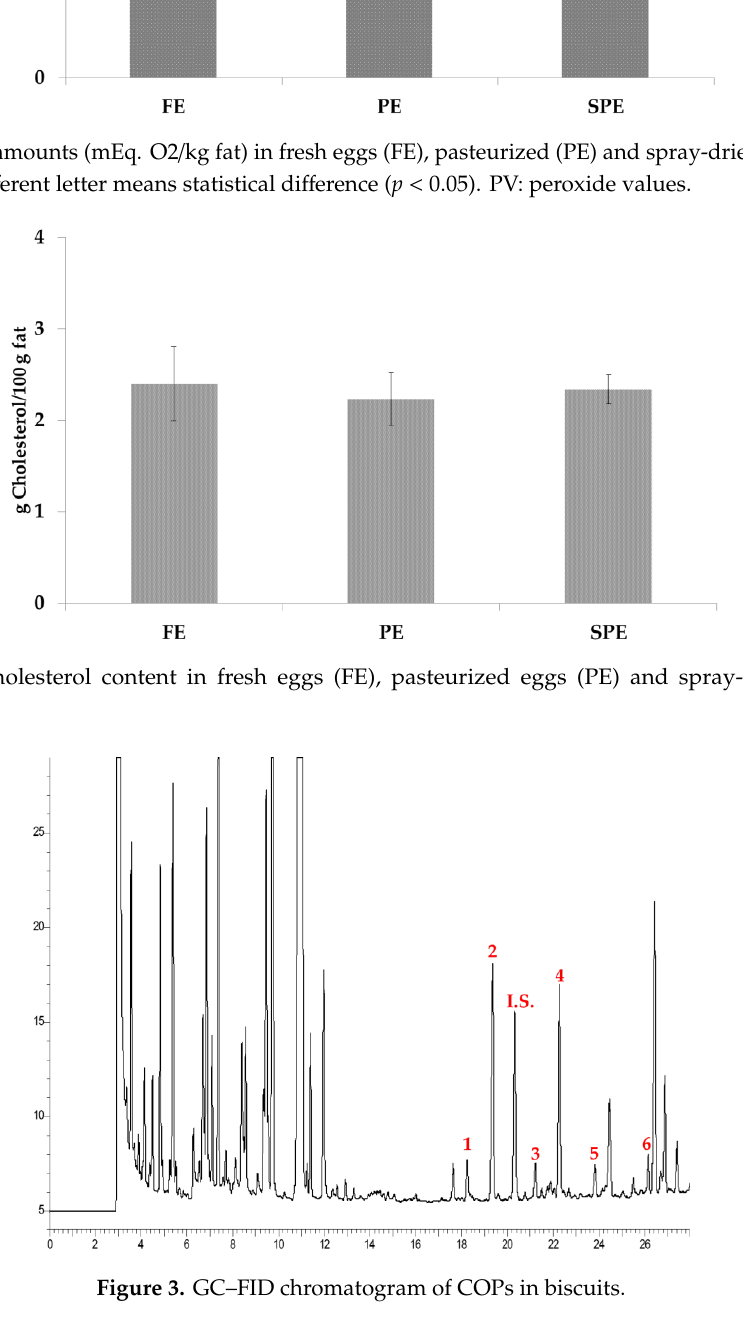
Table 3. COPs content (µg/g fat) in FE, and PE and SPE egg products.